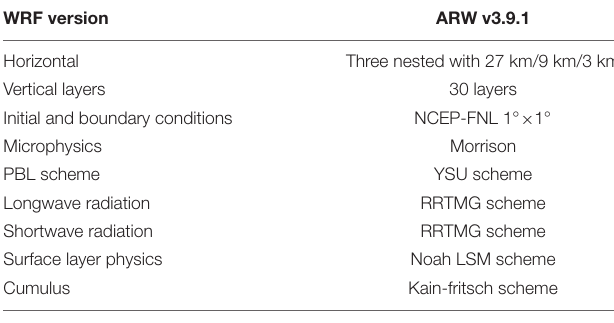
TABLE 1 | Configurations of WRF model.